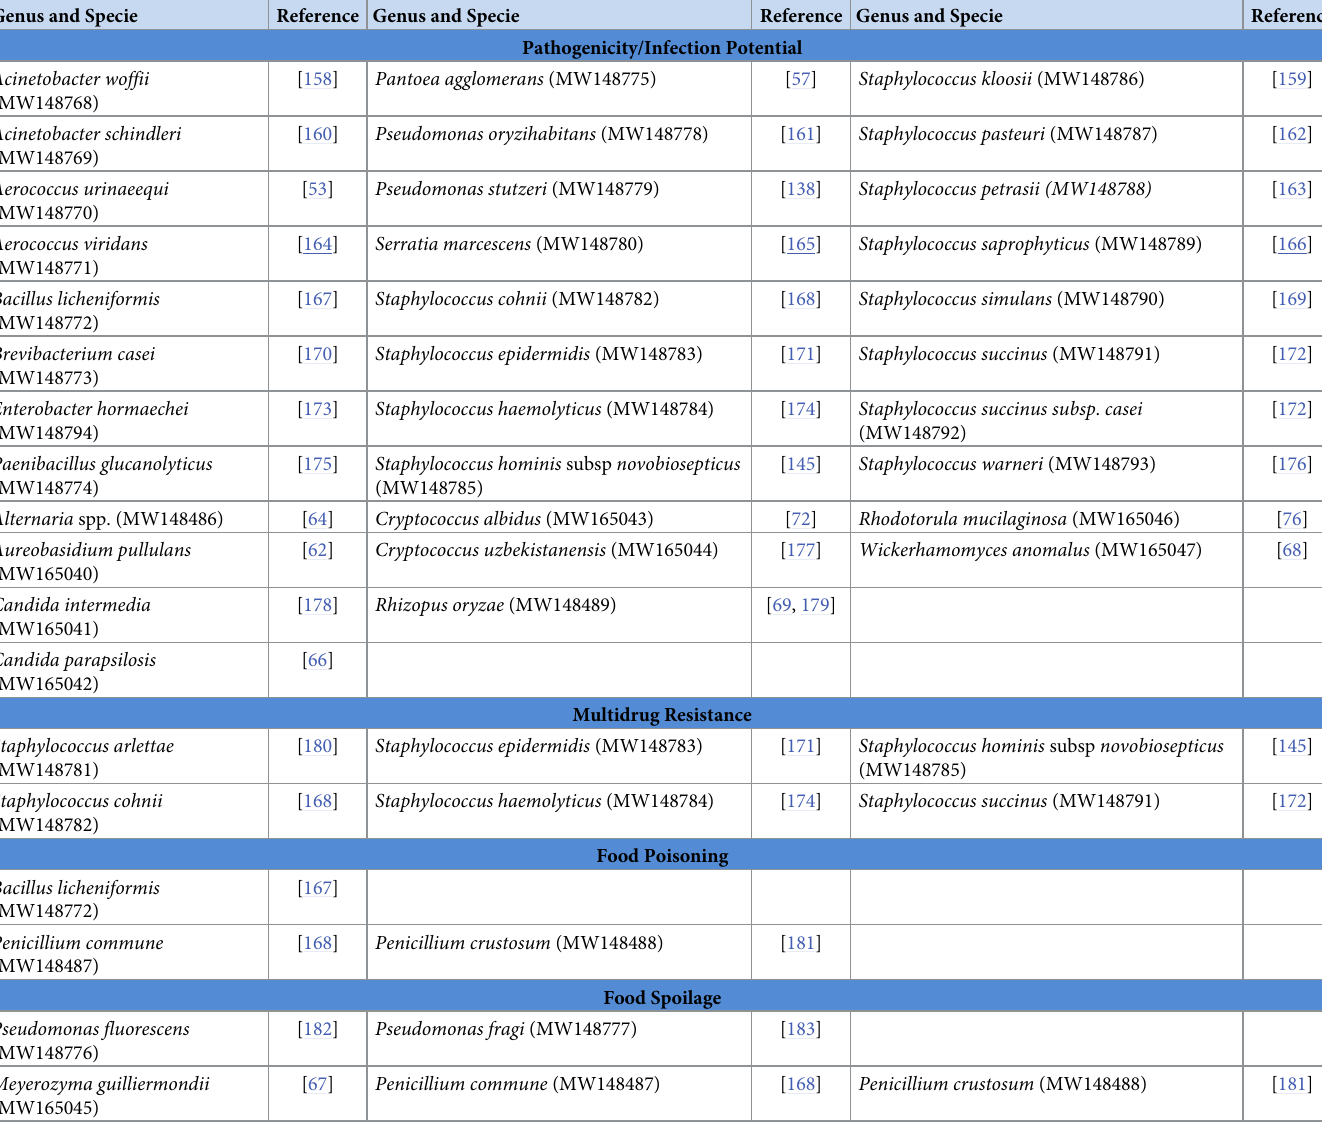
Table 4. Harmful bioaerosols detected and classified alphabetically according to their pathogenicity and infection potential, multidrug resistance, food poisoning and food spoilage potential. Genus and